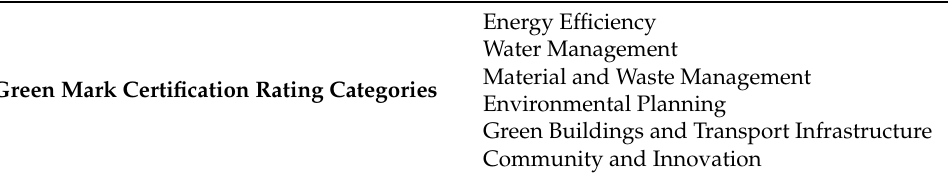
Table 2. Green Mark certification rating categories [75,77].